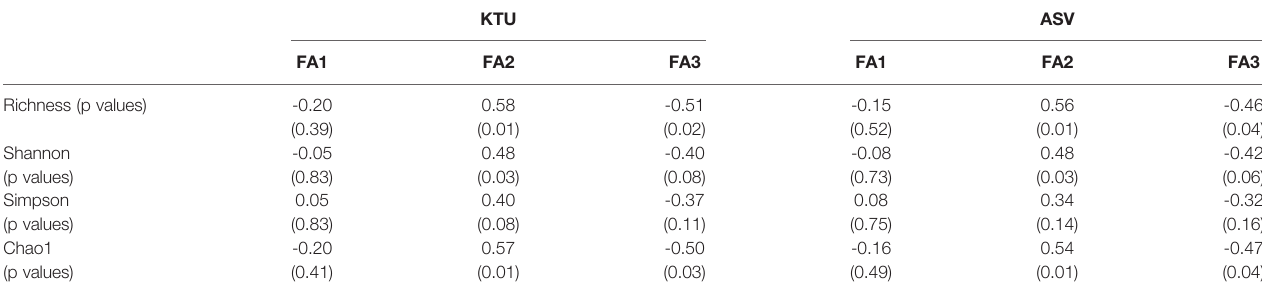
TABLE 2 | The correlation analyses of alpha diversities basing on KTU and ASV with three FAs. KTU ASV